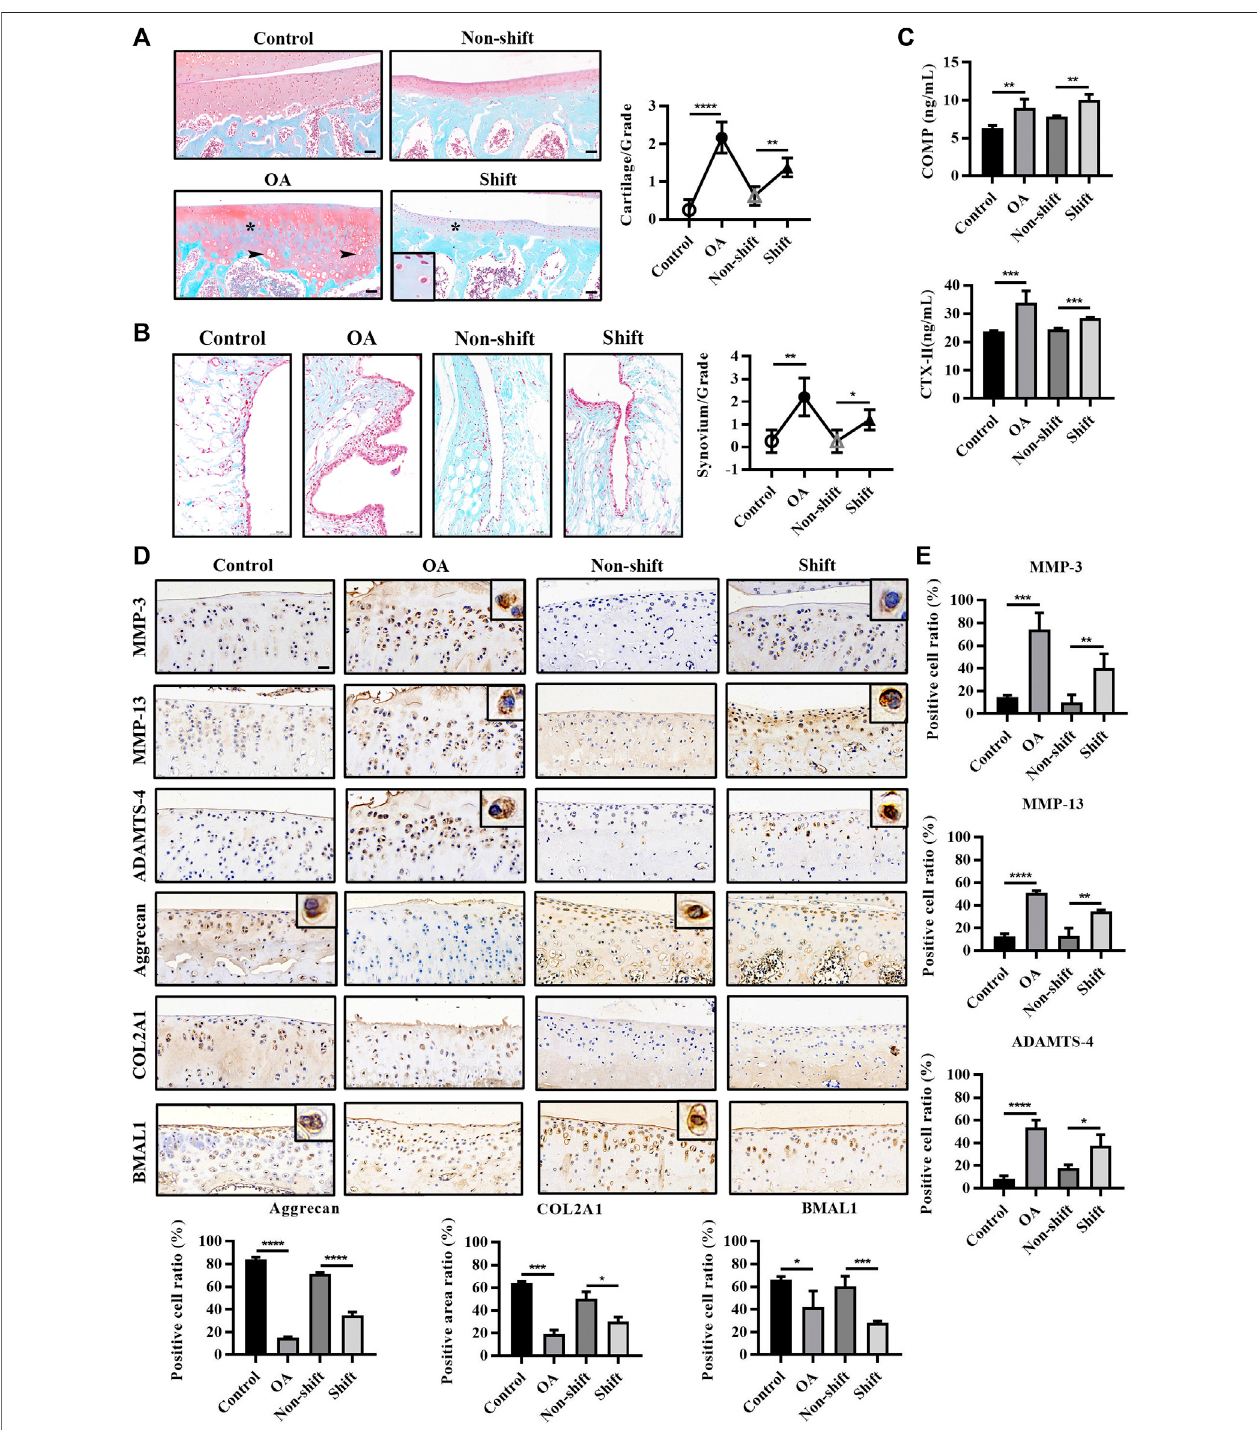
FIGURE2| Pathological changes and immunologicaldetection of knee cartilage in each group. (A) Safranine O and fastgreen staining ofrat tibia cartilage and OARSI cartilage score. Arrows, vacuolar and hypertrophic chondrocytes; asterisk, absence of cationic staining. Magni fi cation (Mag), 200 × . Scale bar, 50 μ m. Results areexpressed as mean ± SD; n (cid:2) 4 – 6. (B) Safranine O and fast green staining of ratkneesynovium. Mag, 200 × . Scale bar, 50 μ m. Results areexpressed as mean ± SD; n (cid:2) 3 – 6. (C) Levels of COMP and CTX- Ⅱ in rat serum in each group. Results are expressed as mean ± SD; n (cid:2) 4 – 6. (D,E) Immunohistochemical staining of MMP-3, MMP-13, ADAMTS-4, Aggrecan, COL2A1, and BMAL1 in chondrocytes. Mag, 200 × . Scale bar, 50 μ m. Results are expressed as mean ± SD; n (cid:2) 4. * p < 0.05, ** p < 0.01, *** p < 0.001, and **** p < 0.0001.